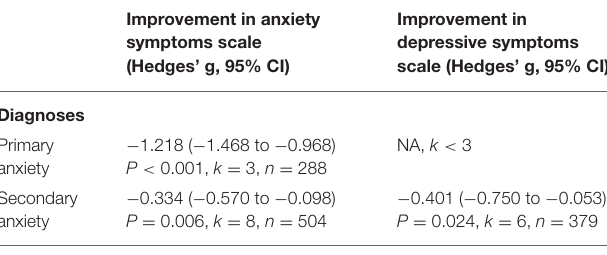
TABLE 2 | Subgroup analyses of CES on anxiety and depressive symptoms divided by primary and secondary